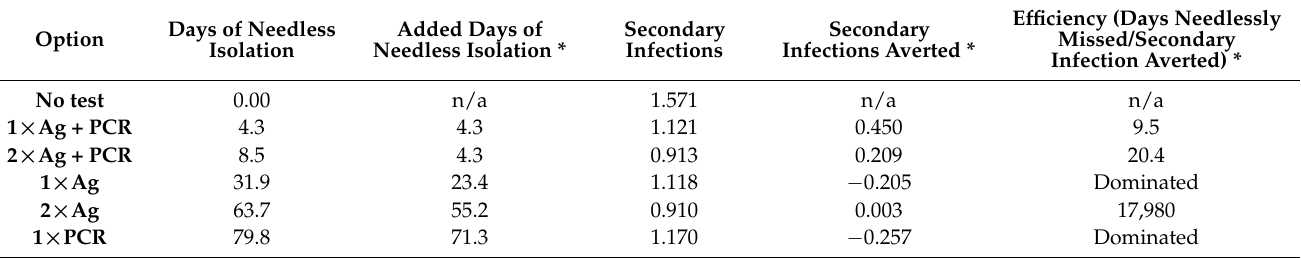
Table 4. Efficiency of testing strategies, per thousand